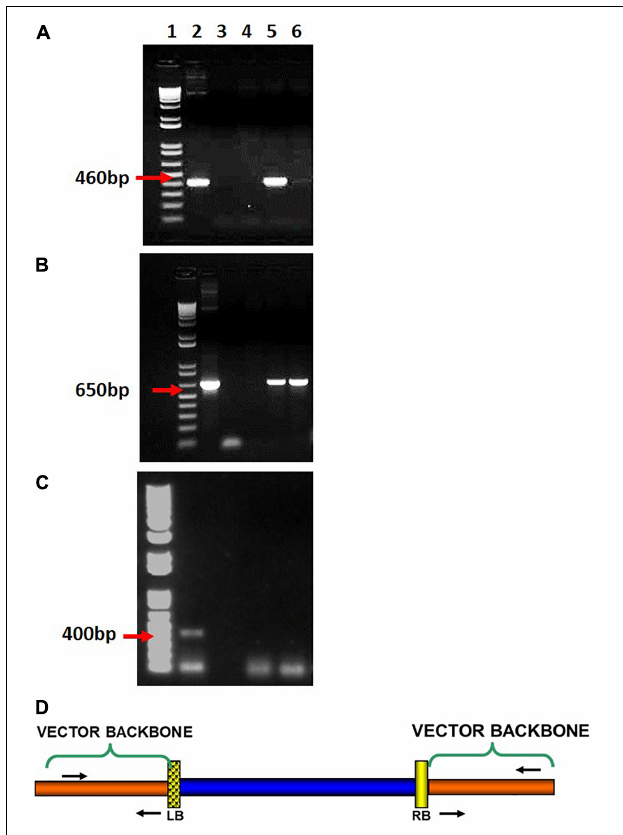
FIGURE 3 | PCR based detection of vector backbone read-through, (A) beyond left border, (B) beyond right border, (C) Agrobacterium carryover tested in transgenic cassava plants (sample gel images). (Lanes: 1-1 kb + ladder; 2-Positive plasmid control; 3- Negative control; 4–6 DNA sample (Transgenic tissue) (D) primer locations to detect beyond LB and RB read-throughs.